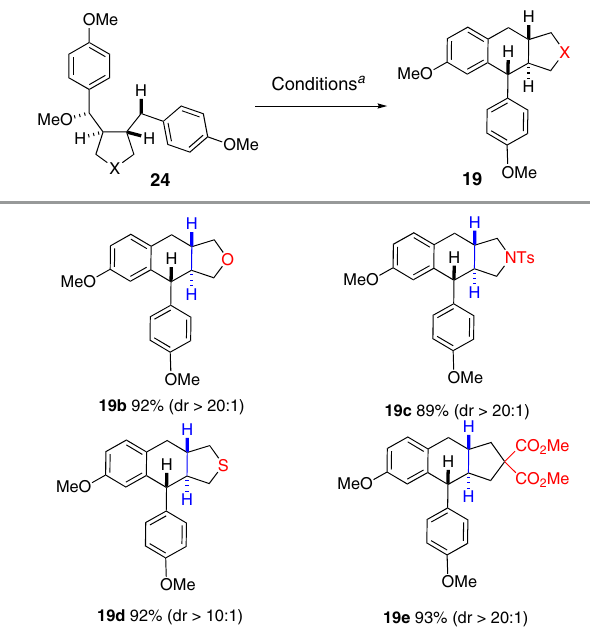
Fig. 8 Synthesis of aza-, thia- and carba-analogs of lignans. Reagents and conditions: (a) BF 3 (cid:129) Et 2 O (2.0 equiv), DCM ( c 0.01 M), 0 °C to RT.